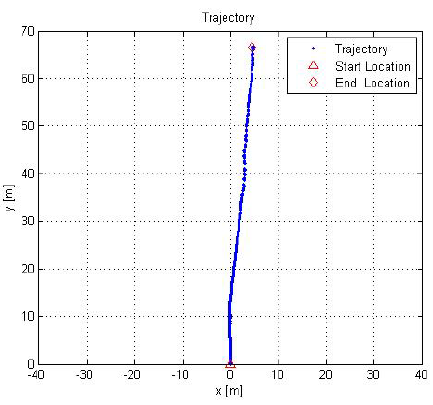
Figure 8. Uphill walk path of 66.46 meters